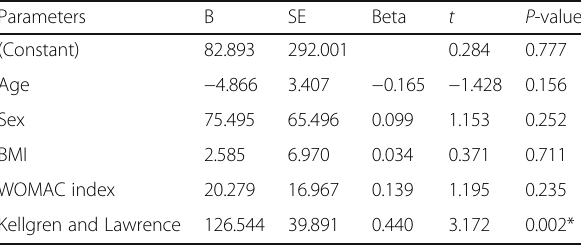
Table 3 The link between urinary CTX-II and the parameters as assessed by multiple linear regression analysis Parameters